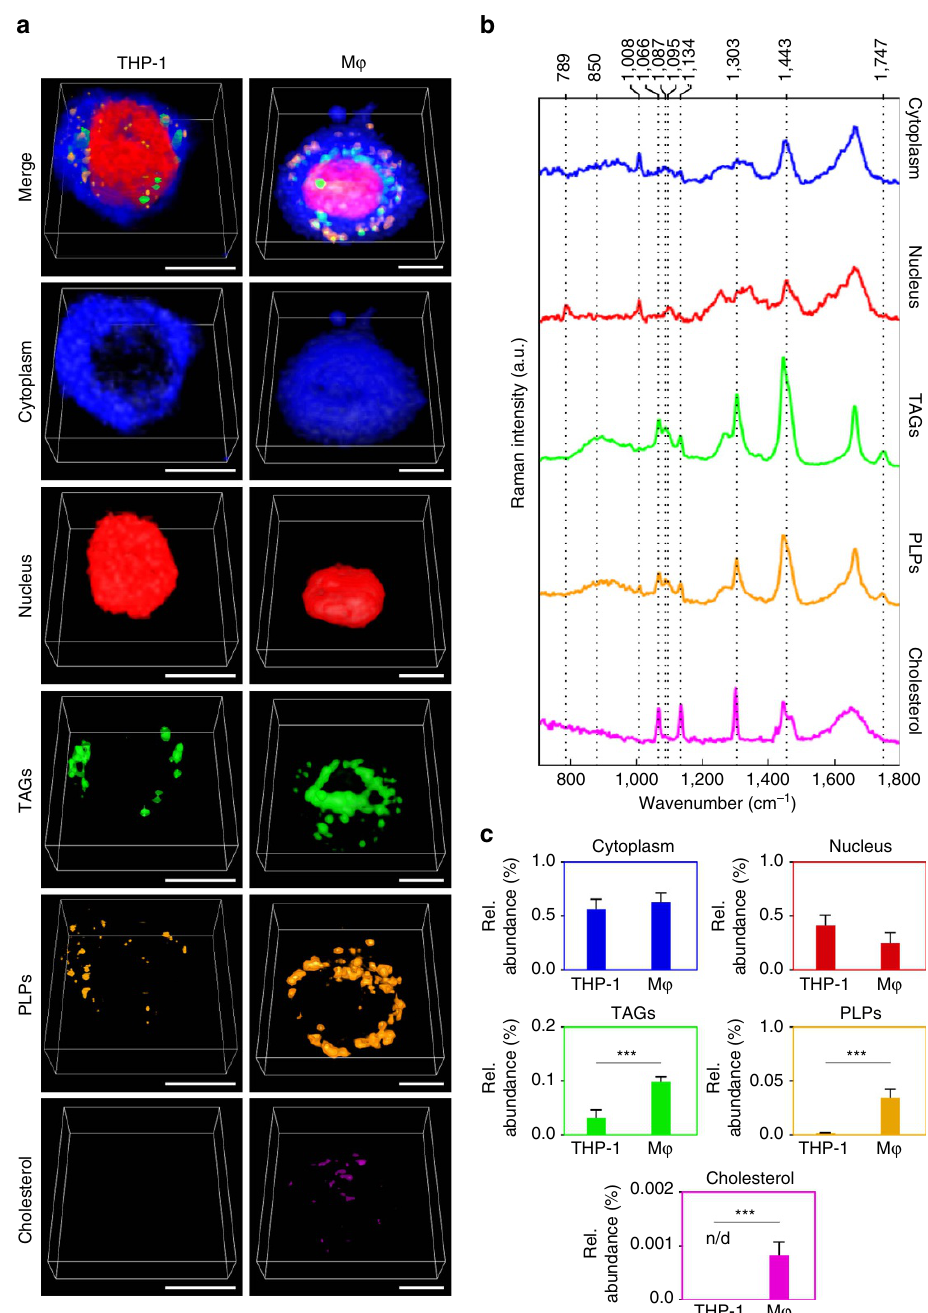
Figure 3 | Lipid analysis in monocyte to macrophage differentiation. ( a ) qVRI identifies the main subcellular components of THP-1 cells ( n ¼ 4 cells) and THP-1 differentiated macrophages (M j ) ( n ¼ 4 cells) representative cells shown, and their corresponding ( b ) endmember Raman spectra from VCA (showing five components); from top to bottom cytoplasm (blue), nucleus (red), triacylglycerols (green), phospholipids (orange), cholesterol (magenta). ( c ) Bar chart of mean abundance values for each subcellular component showing significant differences between the two cells for TAG (two sample t -test, P o 0.001), PLP (two sample t -test, P o 0.001) and cholesterol (two sample t -test, P o 0.001), *** P o 0.001 (n/d, non-detectable). Error bars represent one standard deviation around the mean. Scale bar, 10 m